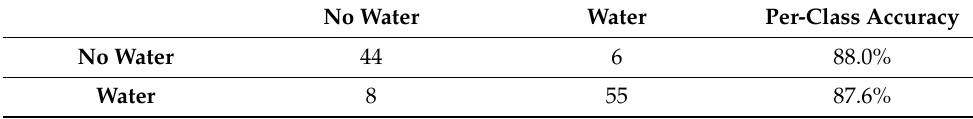
Table 4. Confusion matrix for the MobileNet model.